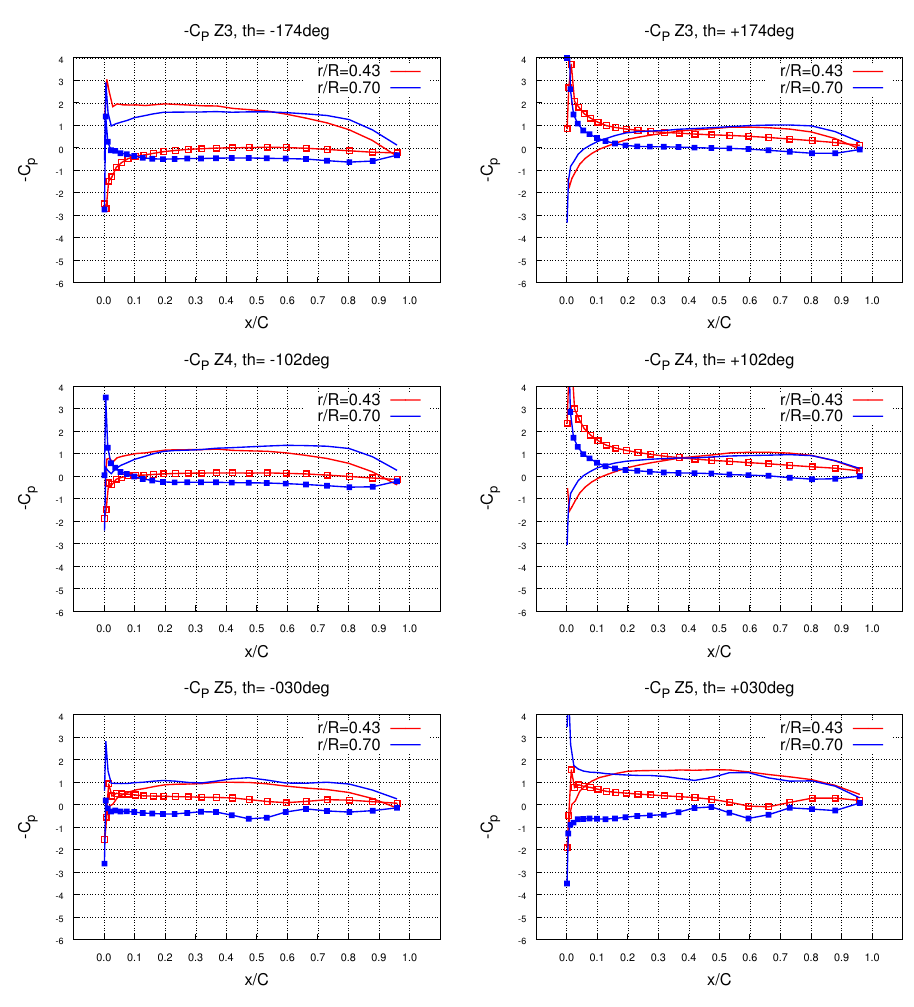
Figure 18. Propulsive performances of the model hull in steady drift motion at 8.4 ◦ , J = 1.12: pressure distribution at starboard propeller sections r / R = 0.43 and 0.7. From top to bottom: propeller blade. ( Left ) portside propeller. ( Right ) starboard